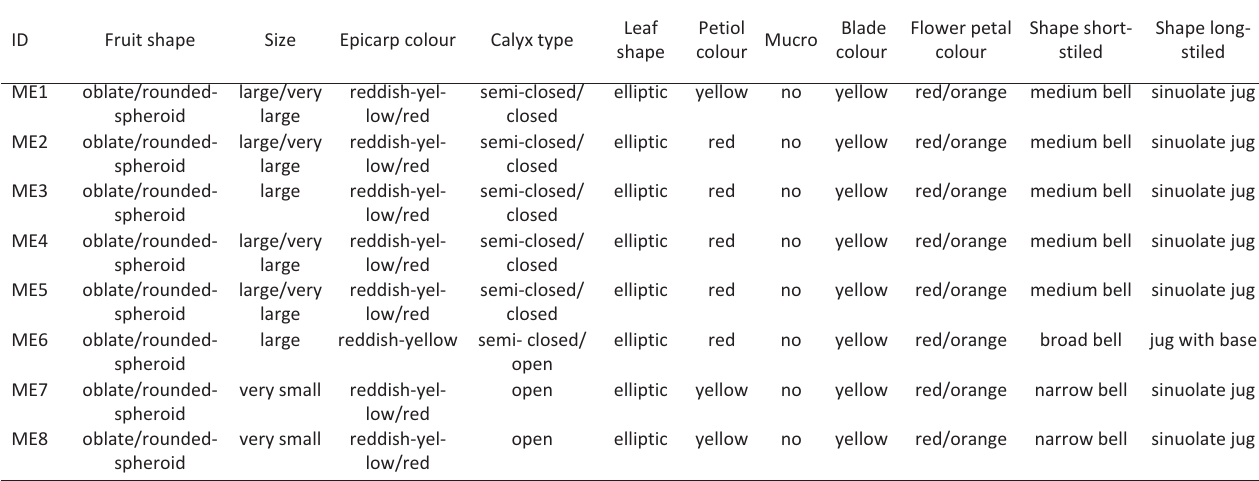
Table 1 ­ Punica granatum L. accessions studied, coded (ID) and main qualitative characteristics of their fruit, leaf and